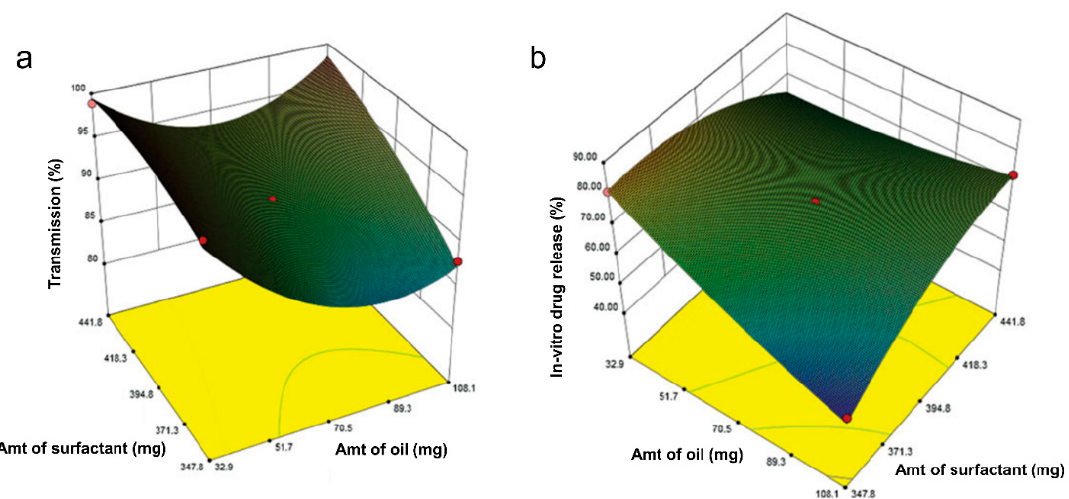
Figure 4. Response surface plot in three dimensions for BBD showing interaction effects between surfactant and oil on % transmission ( a ) and % cumulative drug release ( b ), from the study of zotepine in solid SMEDDS by Dalvadi and coworkers. Adapted from Dalvadi and coworkers [68].